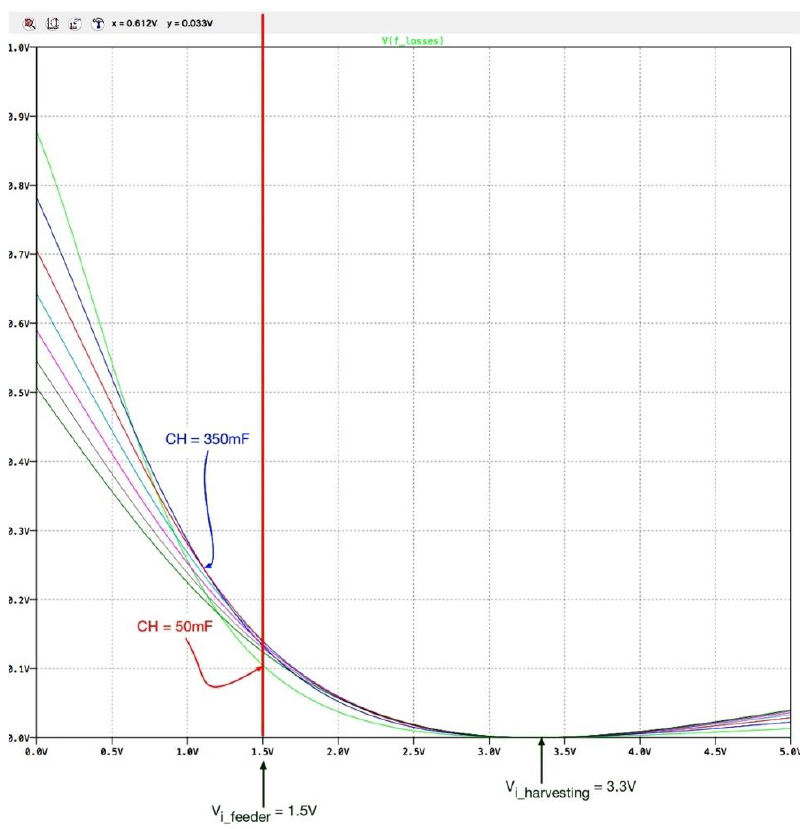
Figure 18. Parametric simulations of the normalized fractional losses for the harvester.